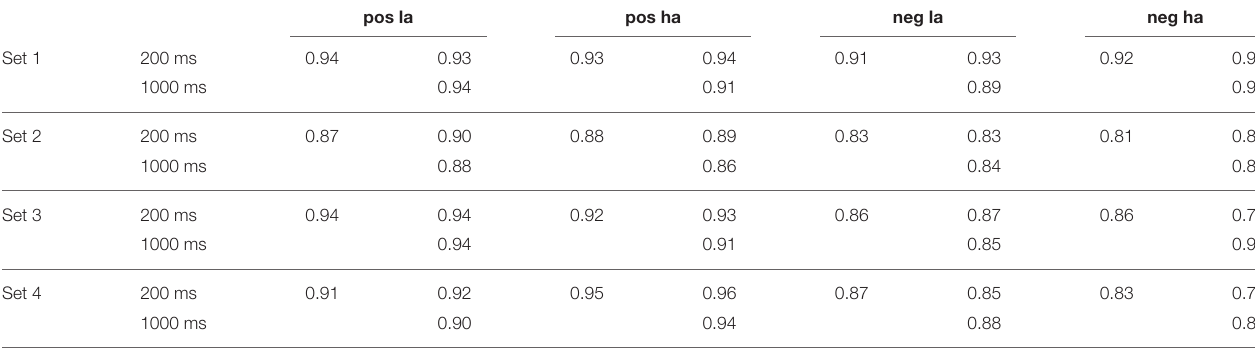
TABLE 2 | Intraclass correlation coefficients (ICC) of the arousal rating procedure.